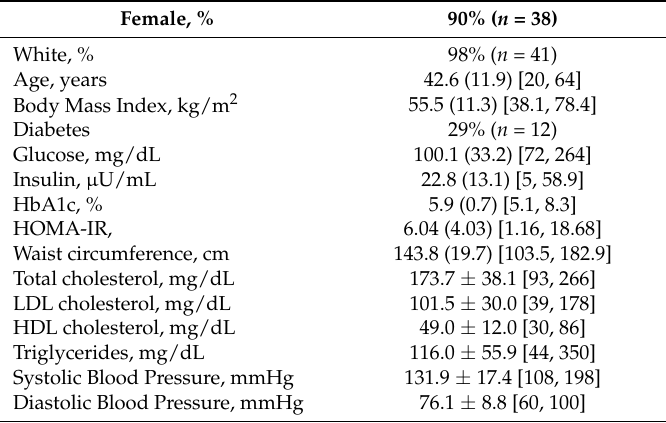
Table 1. Pre-operative sample characteristics ( n = 42)